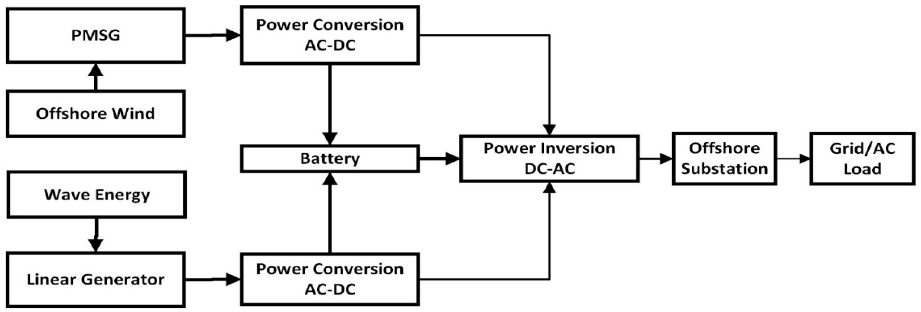
Figure 7. PMSG and linear generator based HOWWE system .